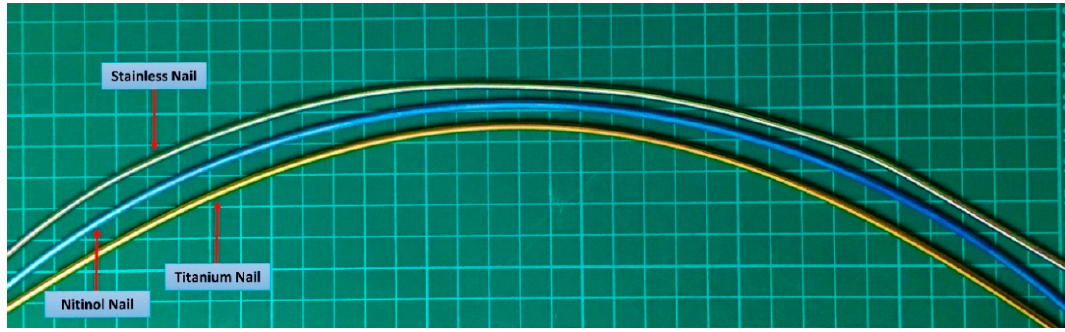
Figure 1. C-shaped nails used in this study.